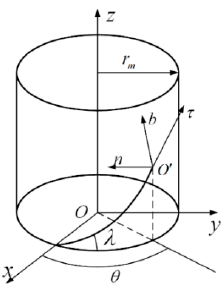
Figure 1. Rotating and local coordinate systems.